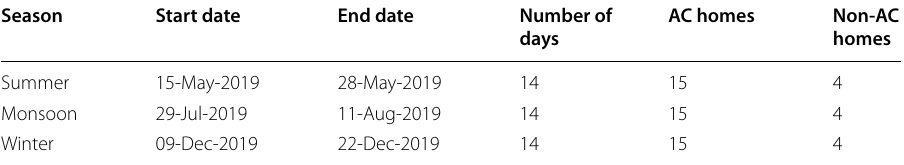
represented the best period of the season for analysis. Out of the 25 dwellings, 23 homes that were available for all the days in at least one season were considered for seasonal analysis. In each season, 19 homes (out of 23 homes) were available for analysis.